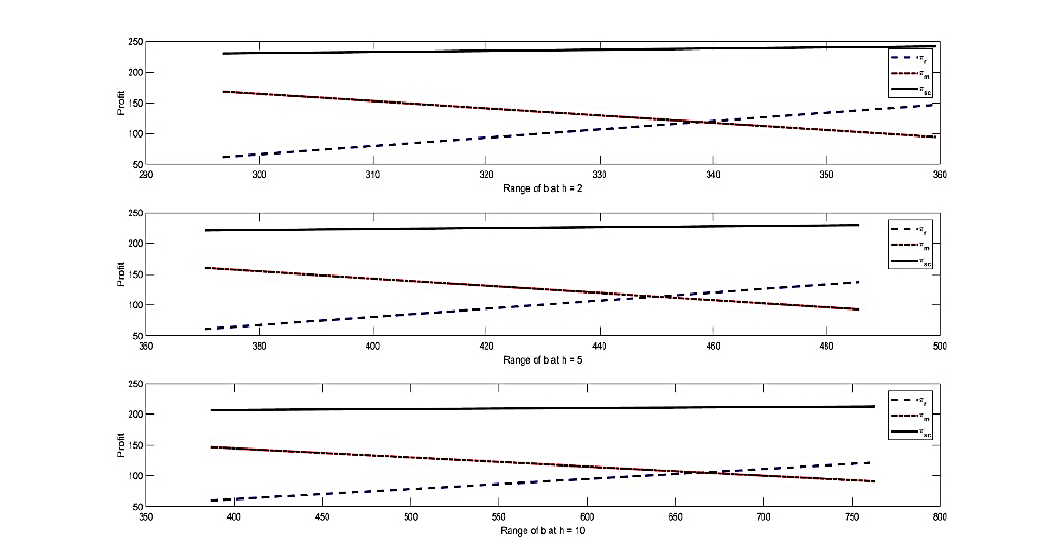
Fig. 7. The trend of variations in firms' profits due to variations in maintenance costs after signing the contract.